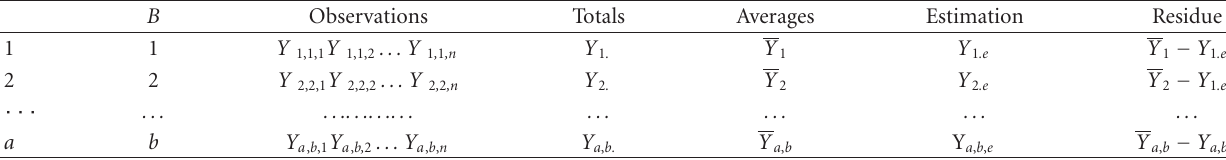
Table 6: Double-Factors experiment plan (2 2 ), typical data.